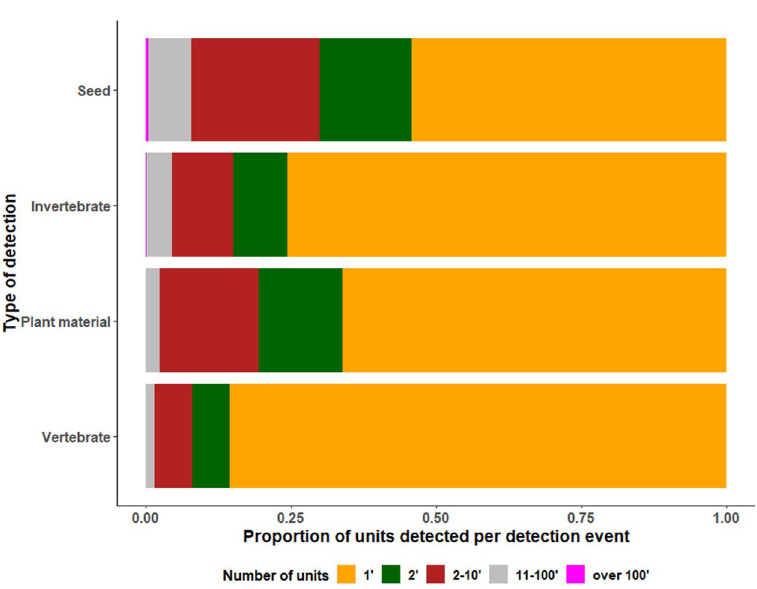
Fig 3. Distribution of detections by type of biosecurity risk material inspected and the number of units detected per inspection for Barrow Island from 2009 to 2015.